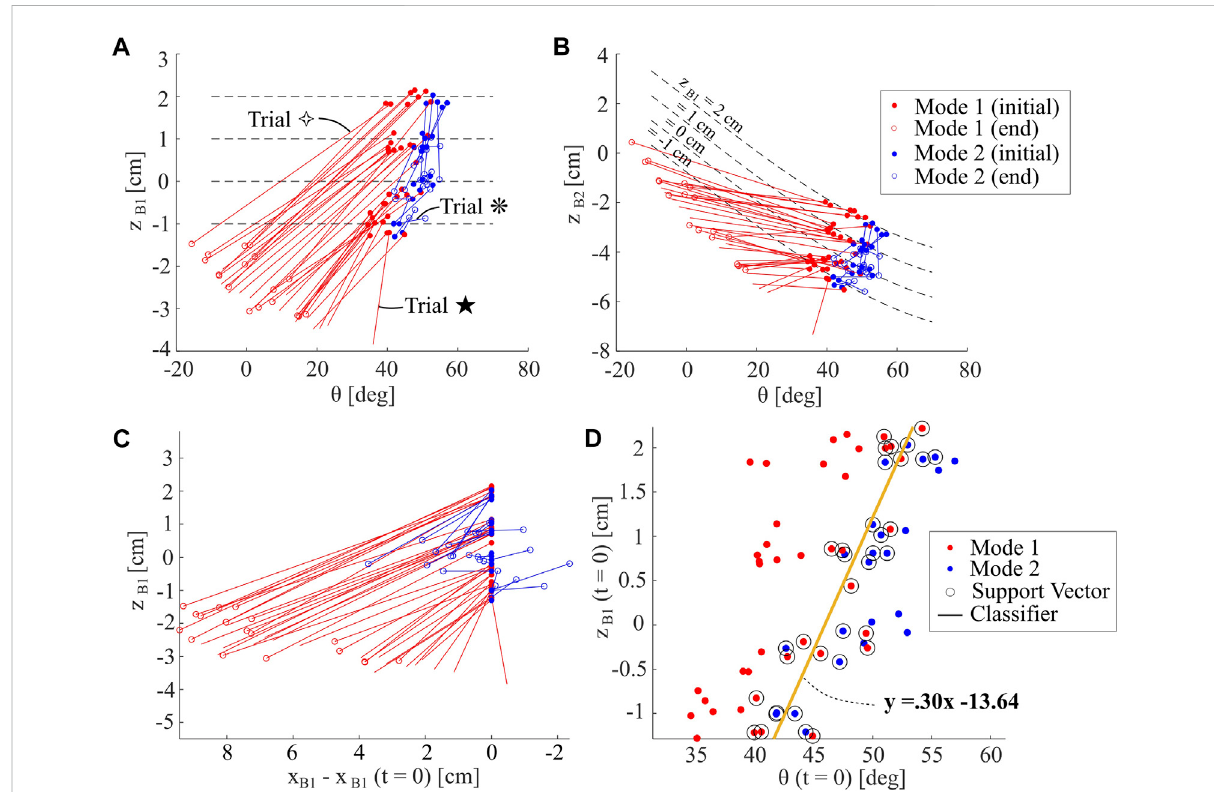
FIGURE 11 Analysis of Sensitivity to Initial Condition. (A) Depth z B 1 and body pitch θ at both initiation and minimum depth of burrow, for many burrowing sequences. Data is separated into modes one and 2. Trials without hollow circles indicate that the Aruco tag was submerged at the minimum depth achieved (B) Identical data to that shown in (A) , but plotted over depth of Point B2 ( z B 2 ) on the robot shell (C) Depth data plotted over change in horizontalposition.Notethathorizontalpositionaxisis fl ippedtomatchthedirectionofthe ^ n x basis (D) SupportVectorMachine(SVM)Analysis of initial condition data in plot A , with a classi fi er separating the two burrowing modes